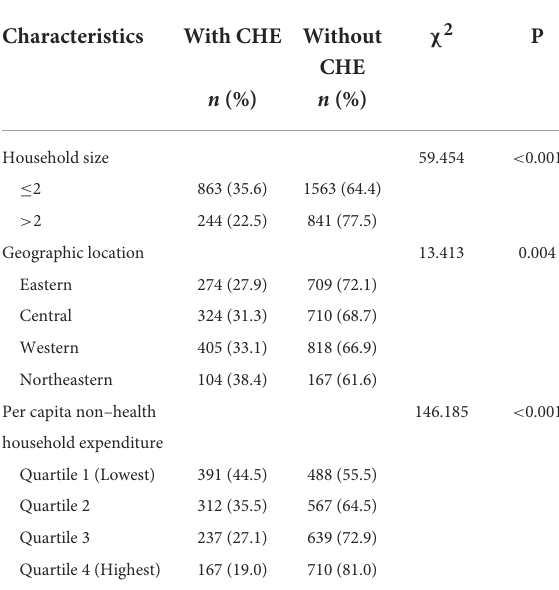
TABLE 3 Incidence of catastrophic health expenditure (CHE) by sociodemographic characteristics ( n =